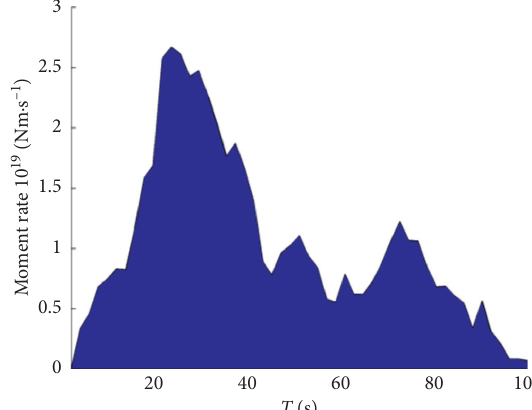
Figure 8: Seismic moment release rate